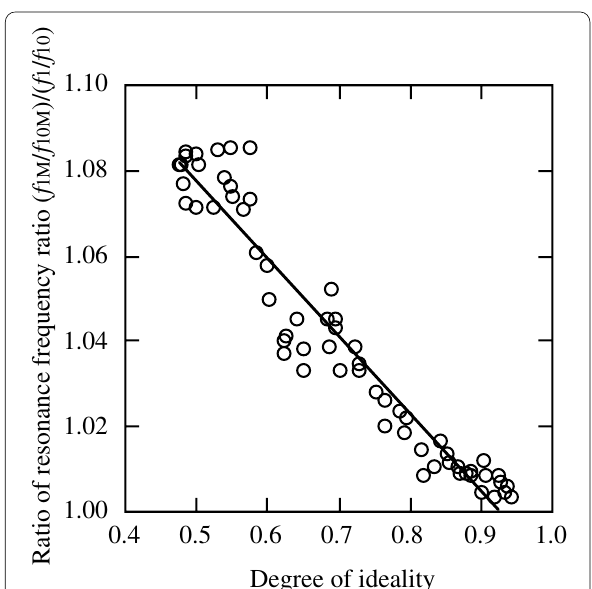
1.00 Fig. 8 Change in the frequency ratio (measured value/theoretical value) with respect to the degree of